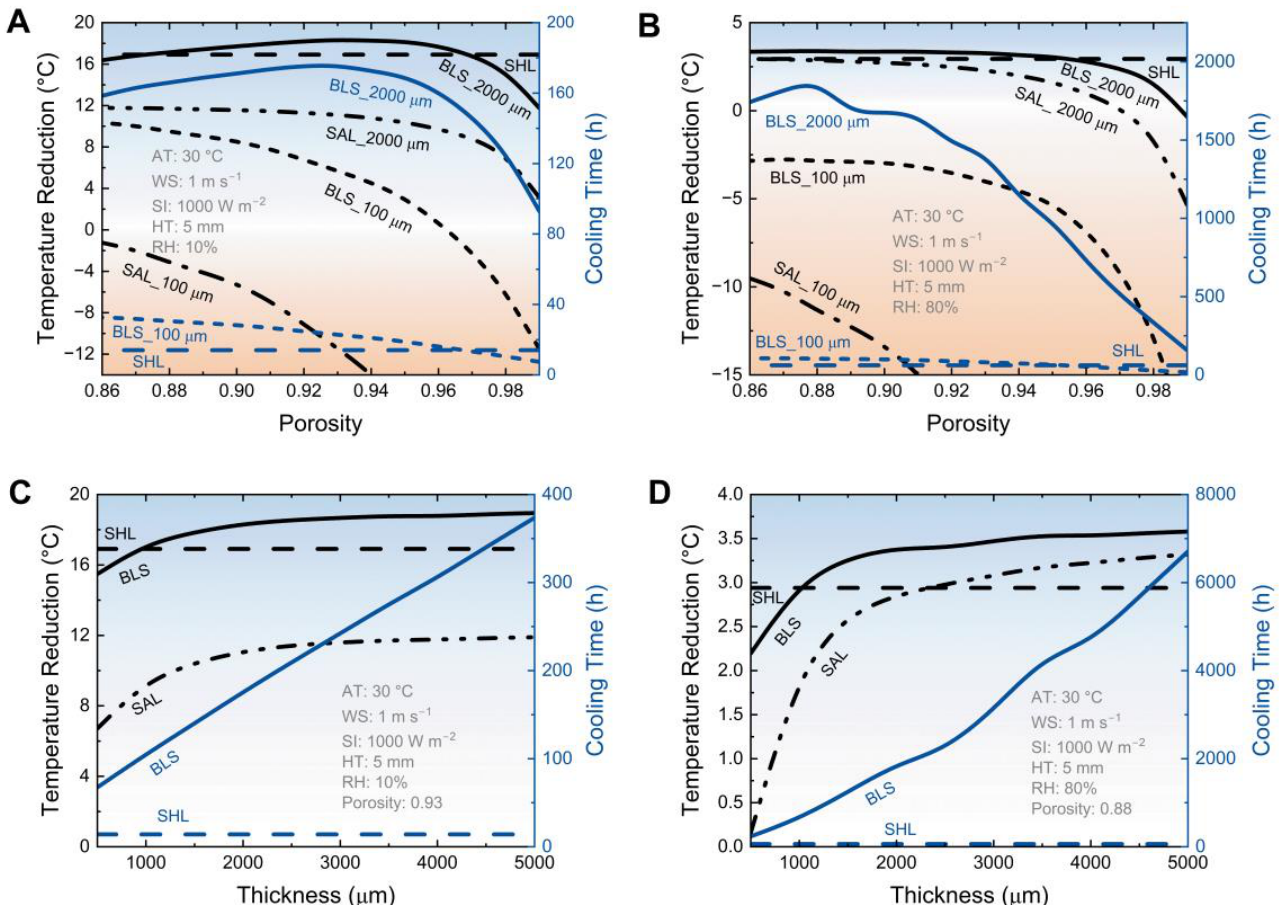
Figure 6. The effect of aerogel structures on cooling performance. Simulated temperature reduction and cooling time span with different porosity at dry ( A ) and humid ( B ) conditions. Simulated temperature reduction and cooling time span with different thicknesses at dry ( C ) and humid ( D ) conditions.